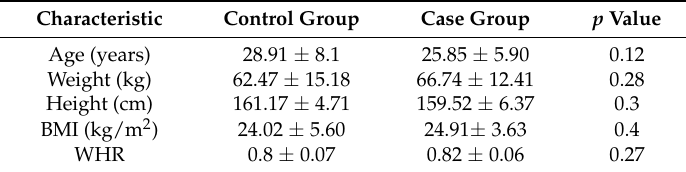
Table 1. Demographic characteristics of case and control groups (Means ± SD).